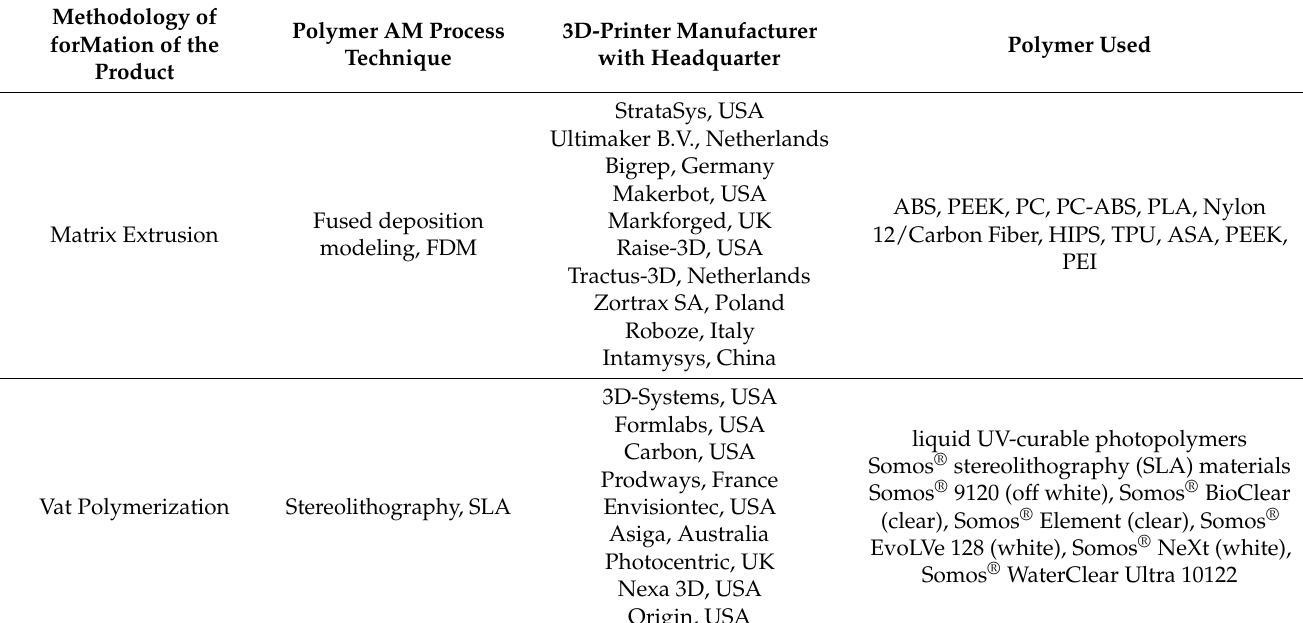
Table 1. Polymer additive manufacturing process and global 3D-printer manufacturers. Methodology